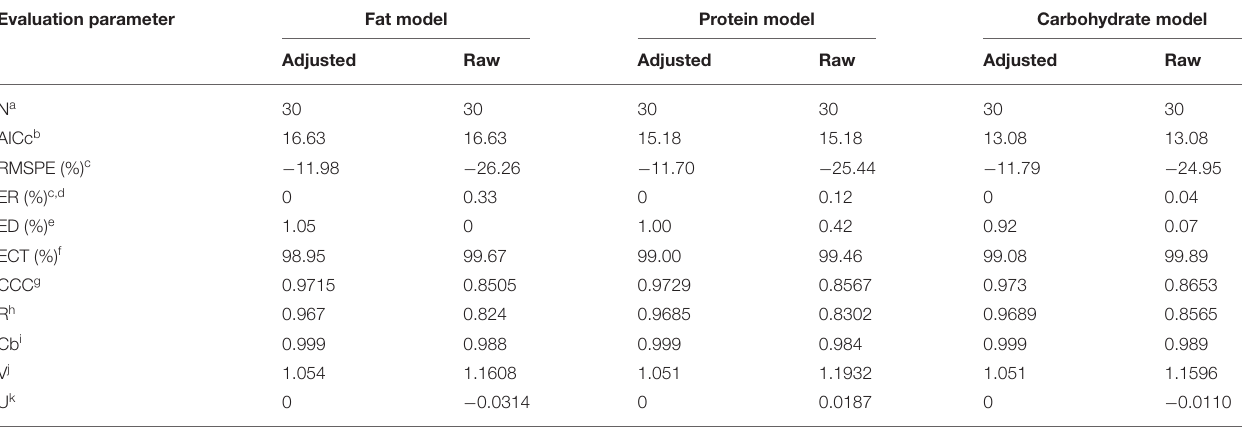
TABLE 9 | Evaluation of model equations using adjusted and raw residuals for total fecal excretion of bile